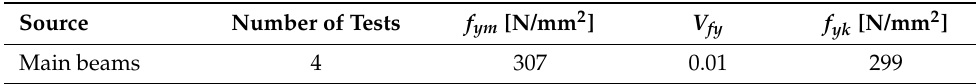
Table 8. Sample parameters for reinforcing steel yield strength.